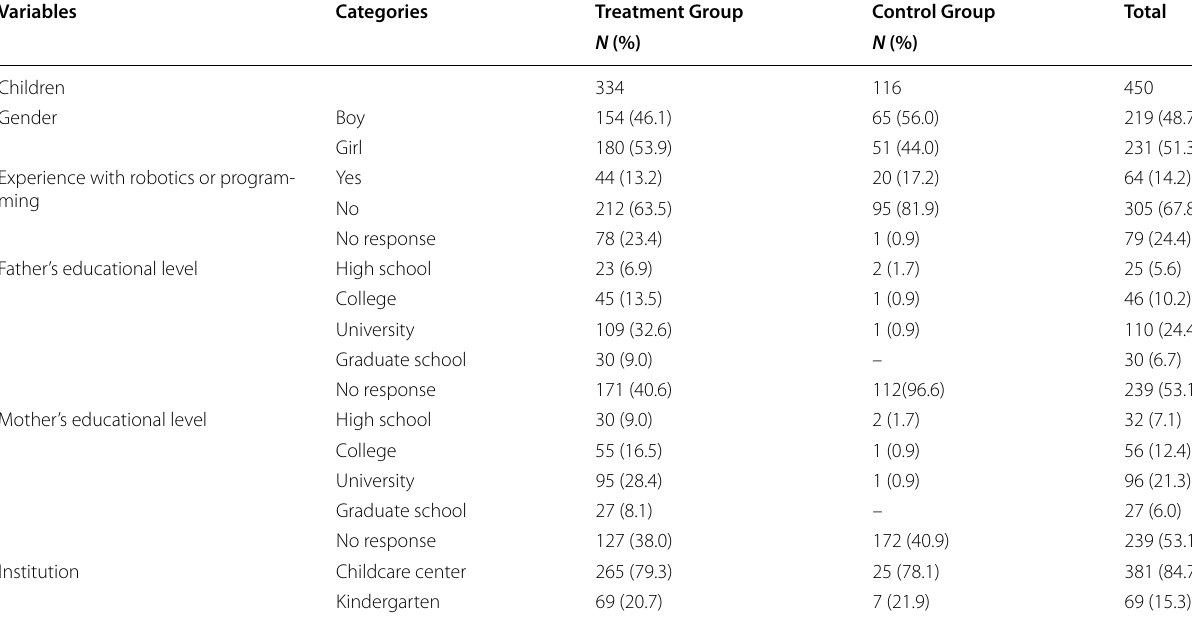
Table 1 Socio-demographic features of children and their families Variables Categories Treatment